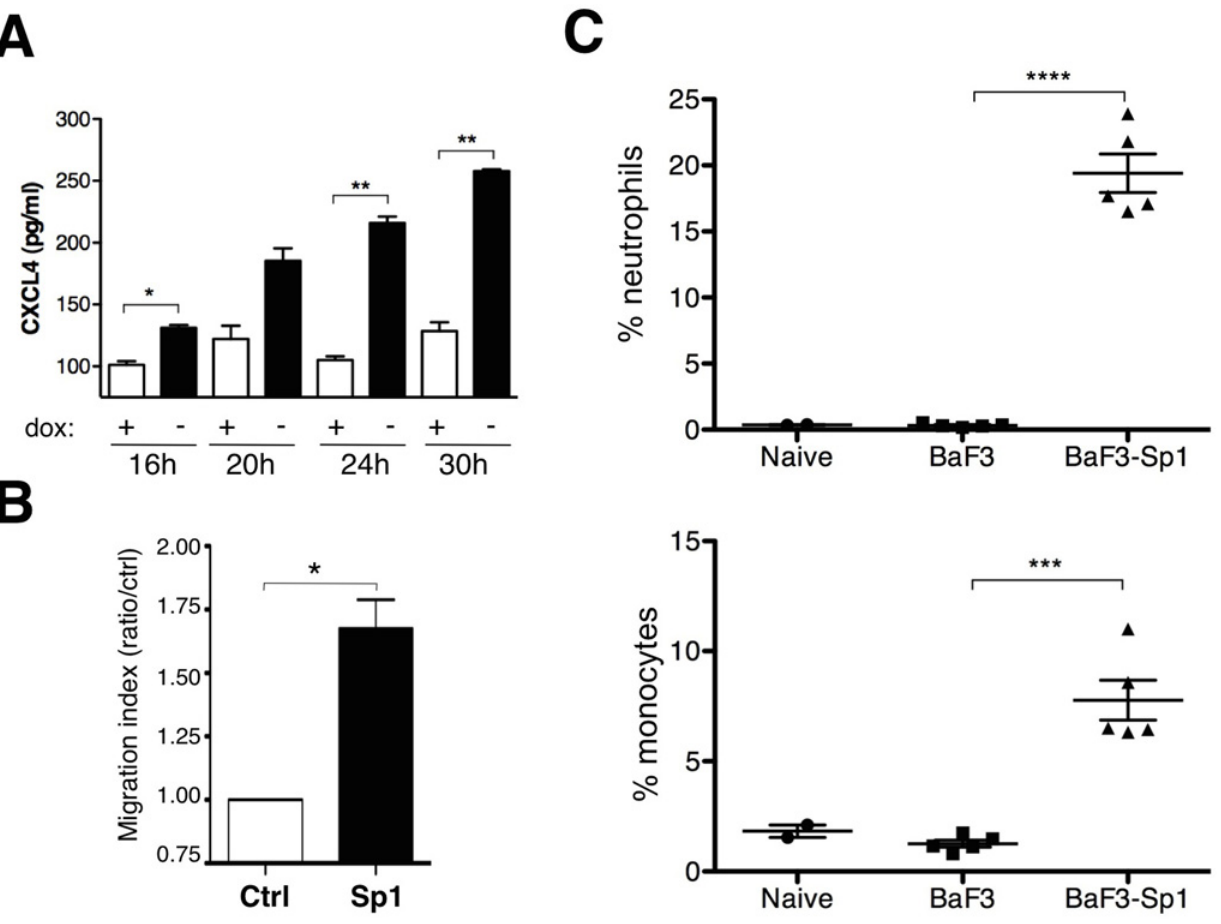
Fig 5. Immune cells are recruited by cells overexpressing Sp1. (A) BaF3-Sp1 cells were grown in the presence (+) or absence (-) of dox. CXCL4 production by BaF3-Sp1 was measured at the indicated times by ELISA. (B) BaF3-Sp1 cells were treated with or without dox for 24 h and incubated in the presence of neutrophils into transwell chambers during 3 h. Neutrophils recruitment (Ly6G + CD11b + cells) was assessed by flow cytometry. (C) BaF3 and BaF3-Sp1 cells were grown 18 h in absence or presence of dox and injected intra-peritoneally into mice. PBS injected mice were used as controls (Naive). Peritoneal washes were performed 6 h after injection. Cells were then harvested and cellular recruitment (CD11b + Ly6G - cells) was estimated by flow cytometry. These results are from one representative out of three independent experiments. Statistical analysis were performed using 2-tailed t tests. Levels of significance are expressed as follows: * P < 0.05; ** P < 0.01; *** P = 0.0001; **** P <